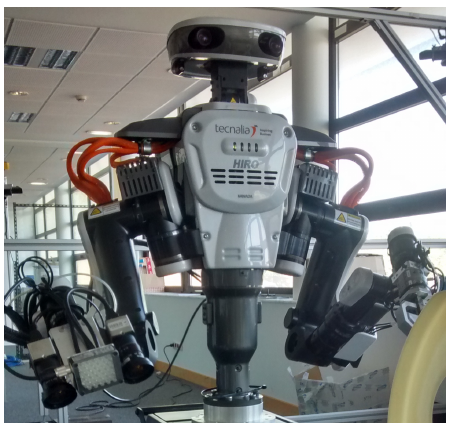
Figure 2. Nextage Open Robot where all developments are being tested.